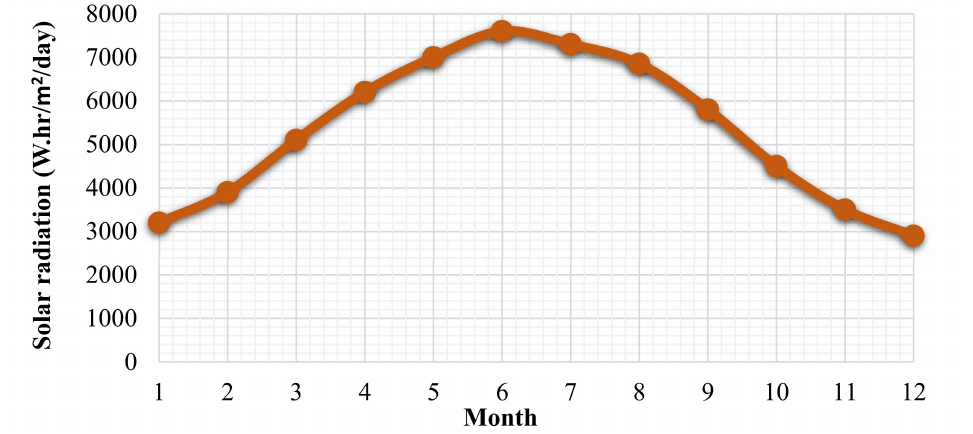
Figure 5. Annual solar irradiation for Zagazig